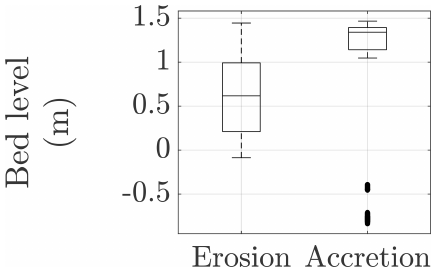
Figure 13. Boxplot of the elevation where erosion or accretion oc- curred extracted from scenario k as